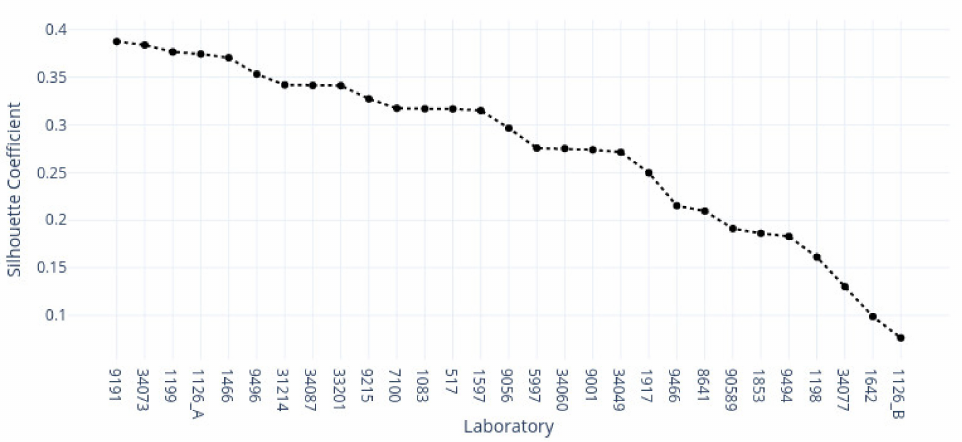
Figure 12. Silhouette scores for the first found cluster (C1) in kidney samples across laboratories.